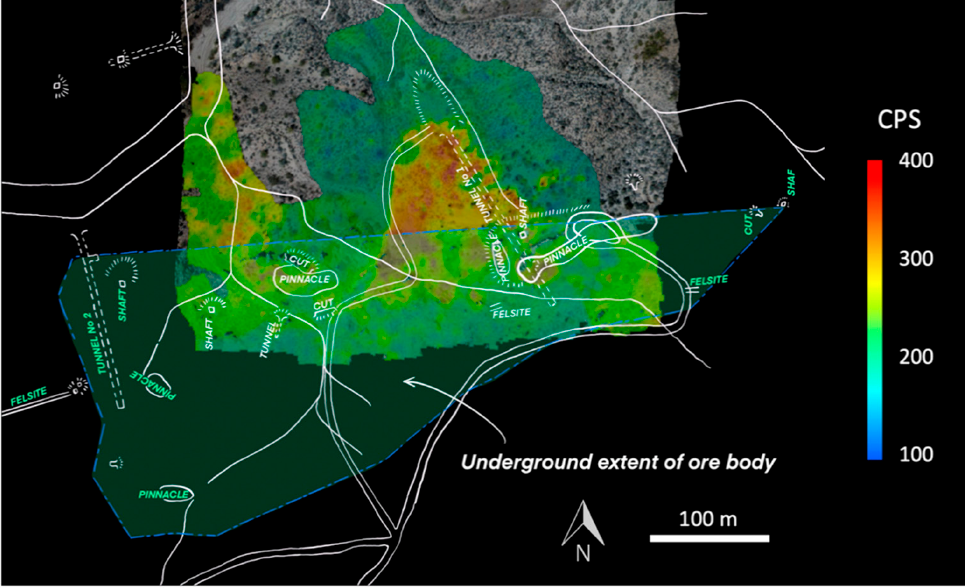
Figure 9. Overlay comprising the historic mine plan (from Arizona Department of Mines and Mineral Resources Mining Collection, (2002)) with the UAV-derived DEM and radiation intensity maps.